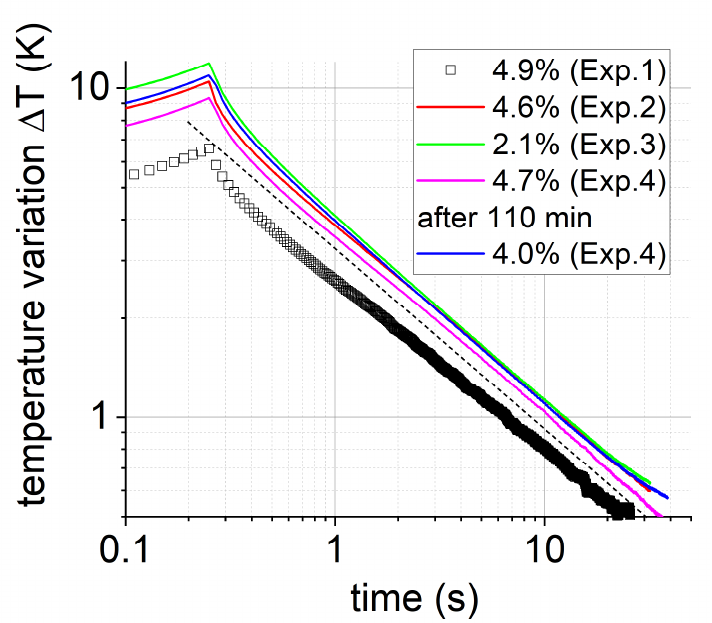
Figure 20. Surface temperature transients recorded in the type 3 sample in different trials with different moisture contents. The dotted line represents a curve according to Equation (1).